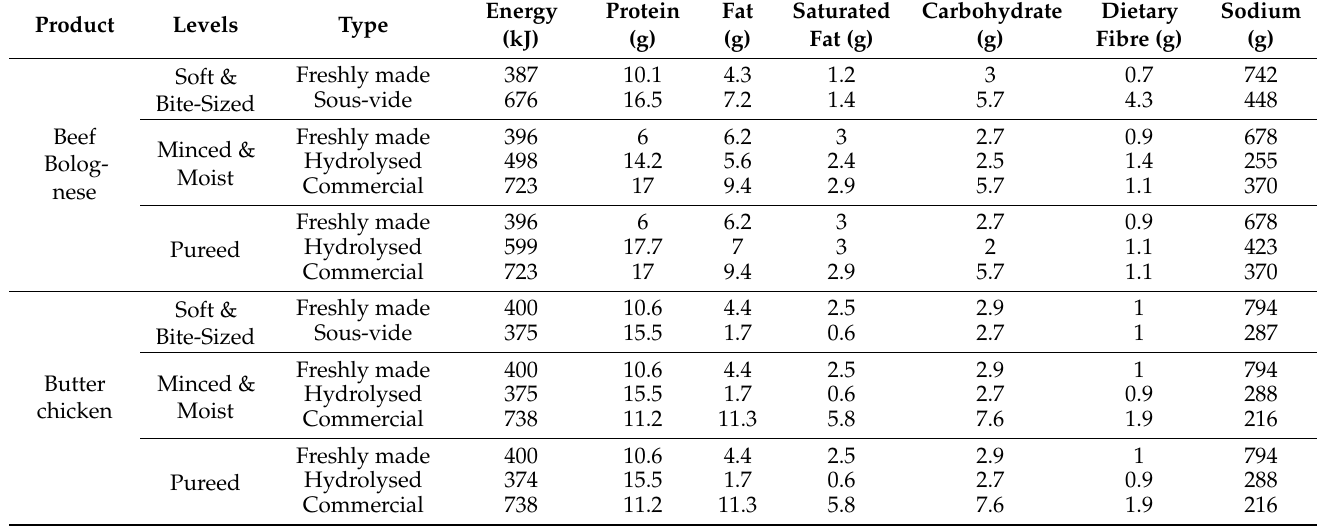
Table 2. The nutritional content of freshly made and readily prepared texture-modified meals used in the focus group (per 100